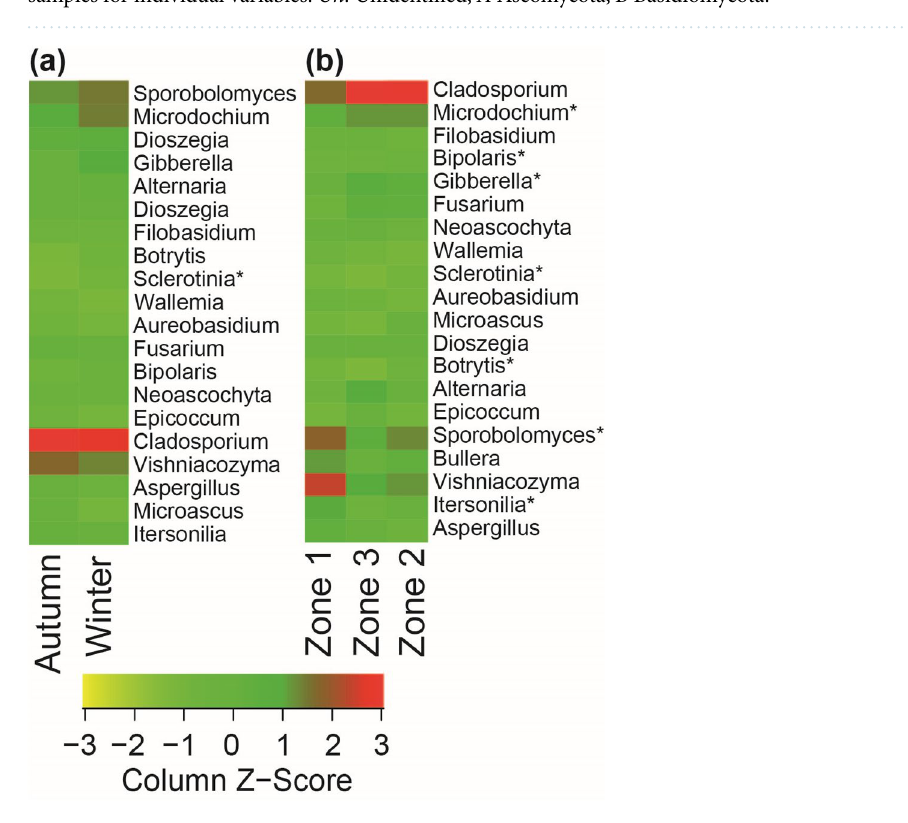
Figure 4. Proportional relative abundances ( a , c ) and OTUs frequency ( b , d ) of airborne fungal compositions at ( a , b ) phyla and ( c , d ) order level recovered from industrial grain mills. The data represent average reads per samples for individual variables. Un . Unidentified, A Ascomycota, B Basidiomycota.